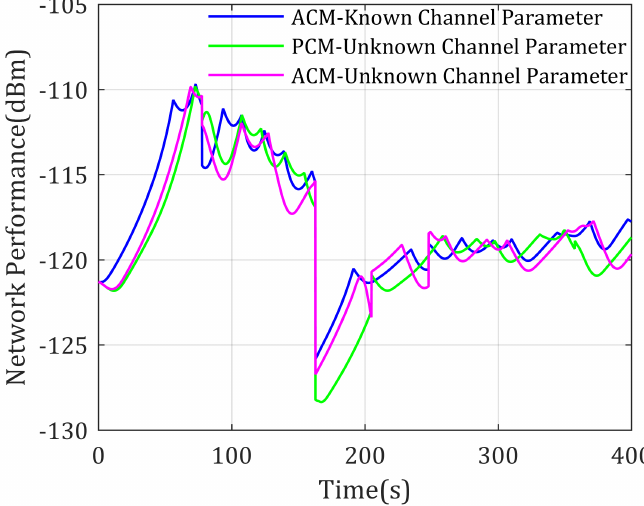
Figure 15. Network performance for two mobile agents end-to-end communication with unknown channel